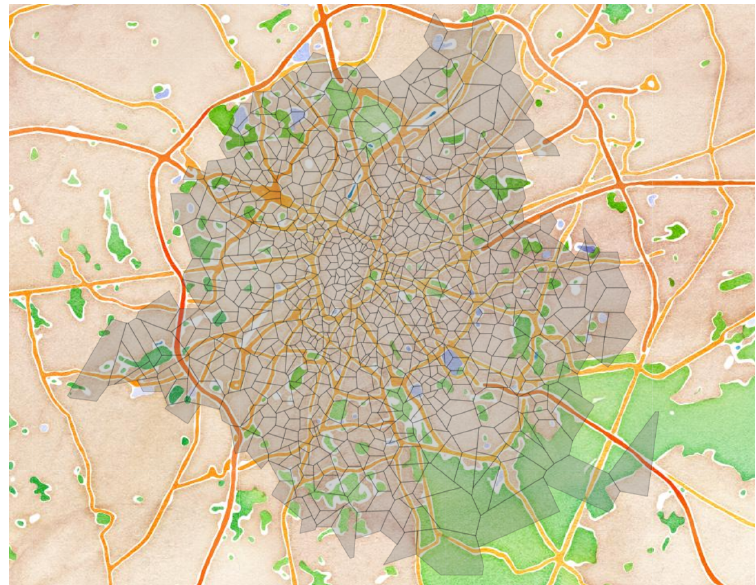
Figure 2. The 880 Proximus TACS covering the city of